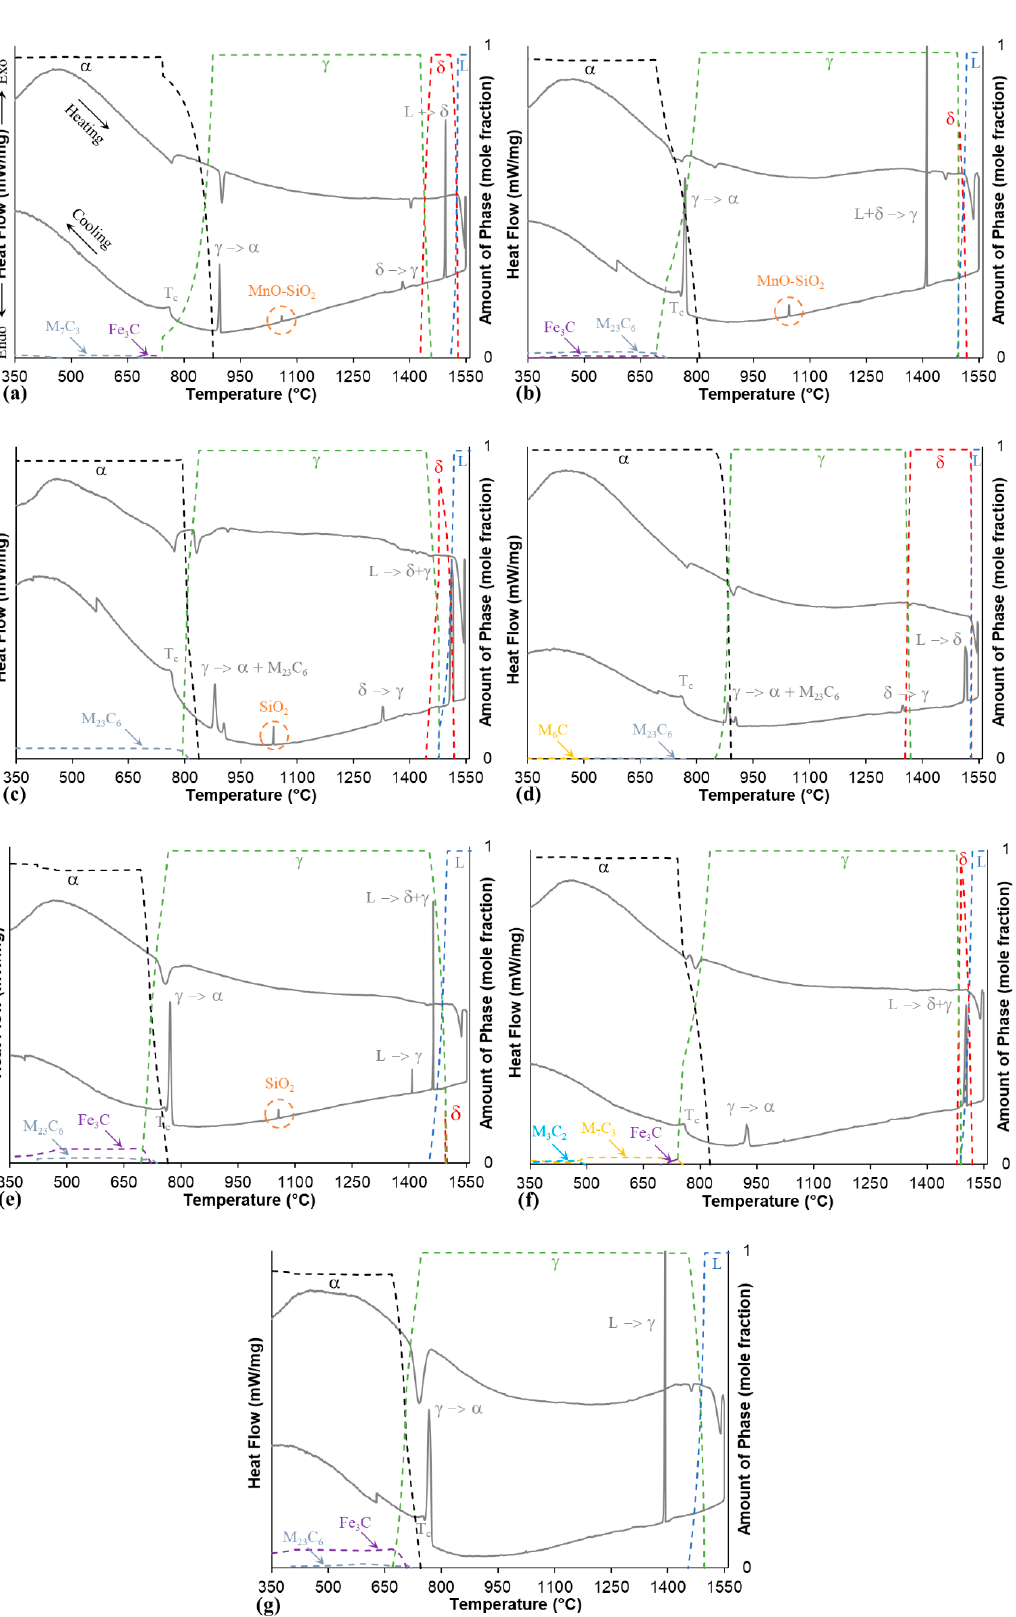
Figure 8. Di ff erential scanning calorimetry (DSC) thermograms (solid lines) and calculated equilibrium phase transformations (dashed lines) for alloys: ( a ) W-1, ( b ) W-2, ( c ) W-3, ( d ) W-4, ( e ) WT-2, ( f ) G-1 and ( g )